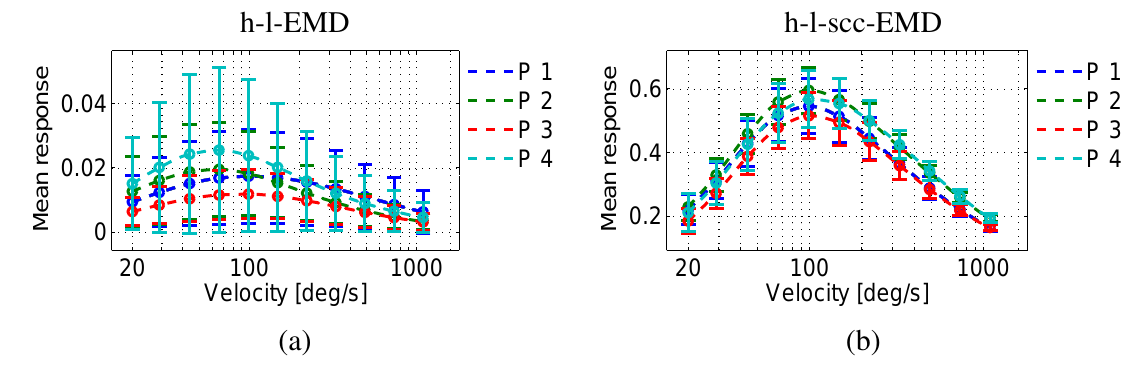
Figure 10. Velocity tuning curves of the h-l-EMD array and the h-l-scc-EMD array for all four panoramic images (P1–P4, see Figure 4). Changing the pattern strongly affects the amplitude of the response peak in the h-l-EMD model ( a ). For the h-l-scc-EMD array ( b ), the differences between responses to different panoramic images are less pronounced, but a small variability of the response amplitude